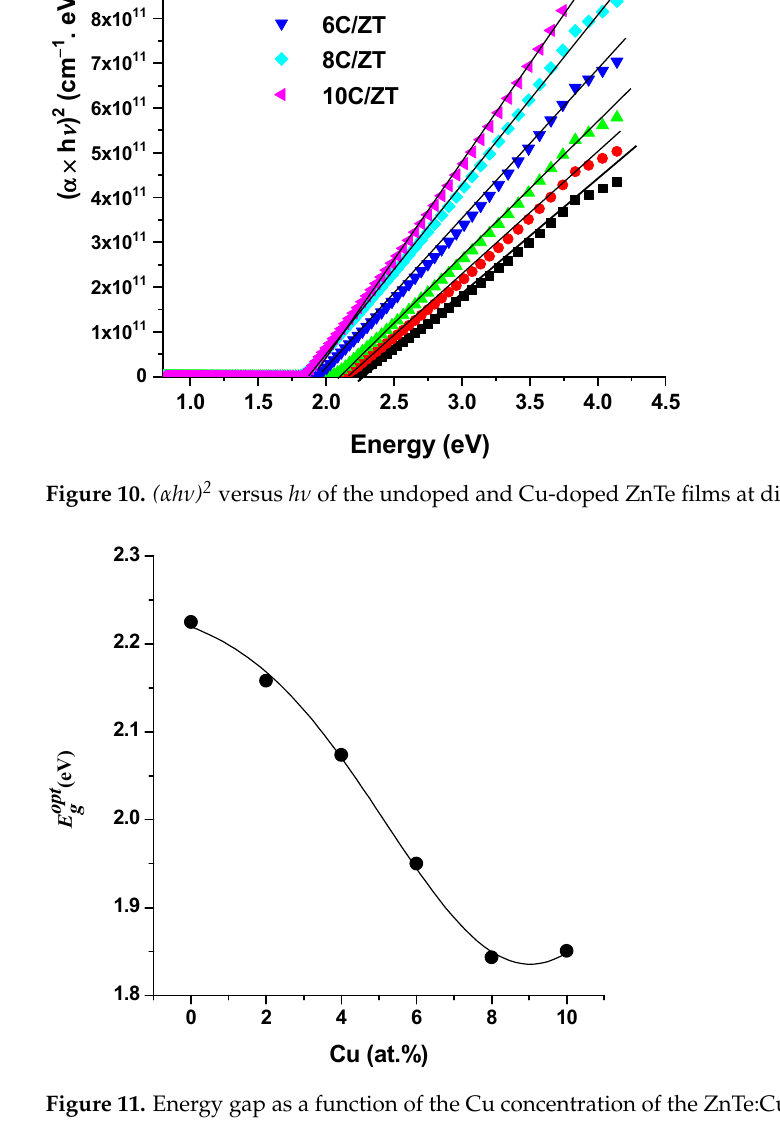
Figure 11. Energy gap as a function of the Cu concentration of the ZnTe:Cu films.